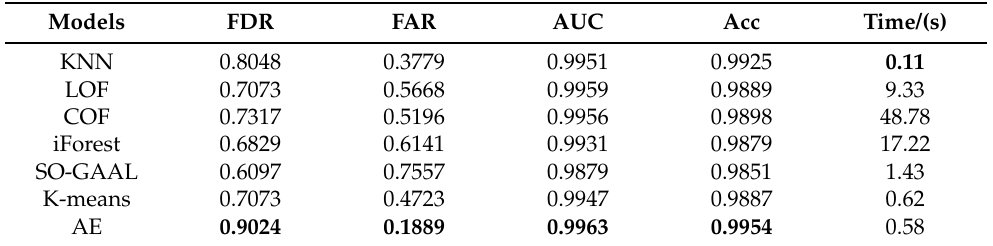
Table 3. All models run over five times with random initializations and report the mean results. Where Acc is an abbreviation for accuracy. The method with the best performance on each dataset is